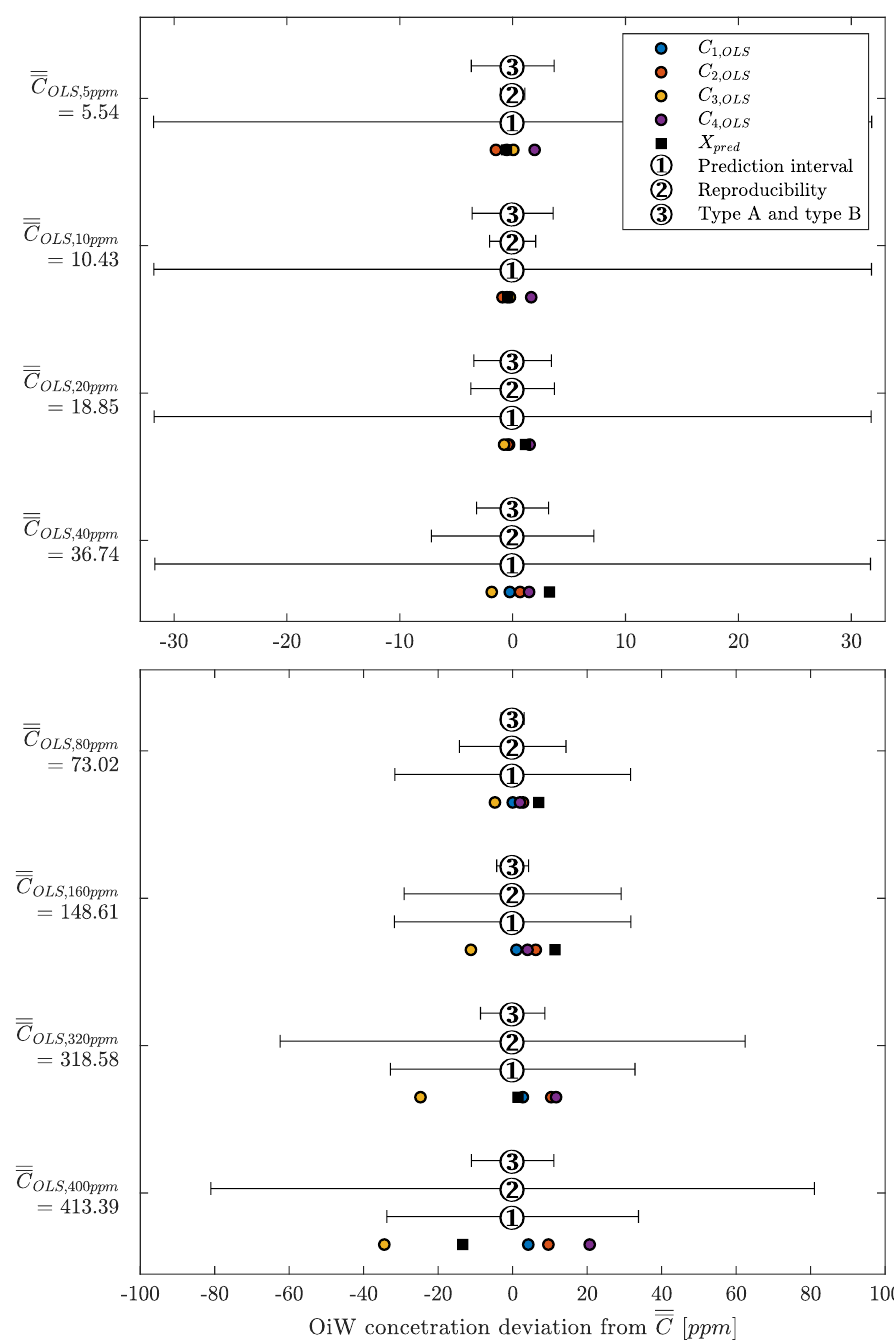
Figure 17. The analysis of three different methods for determining the best estimation of the OiW monitors’ uncertainty based on OLS in the entire range of interest. The grand mean for each concentration is used as a reference point and categorized on the y-axes. The plot is divided into two subplots for better visualization of the OiW concentration range of